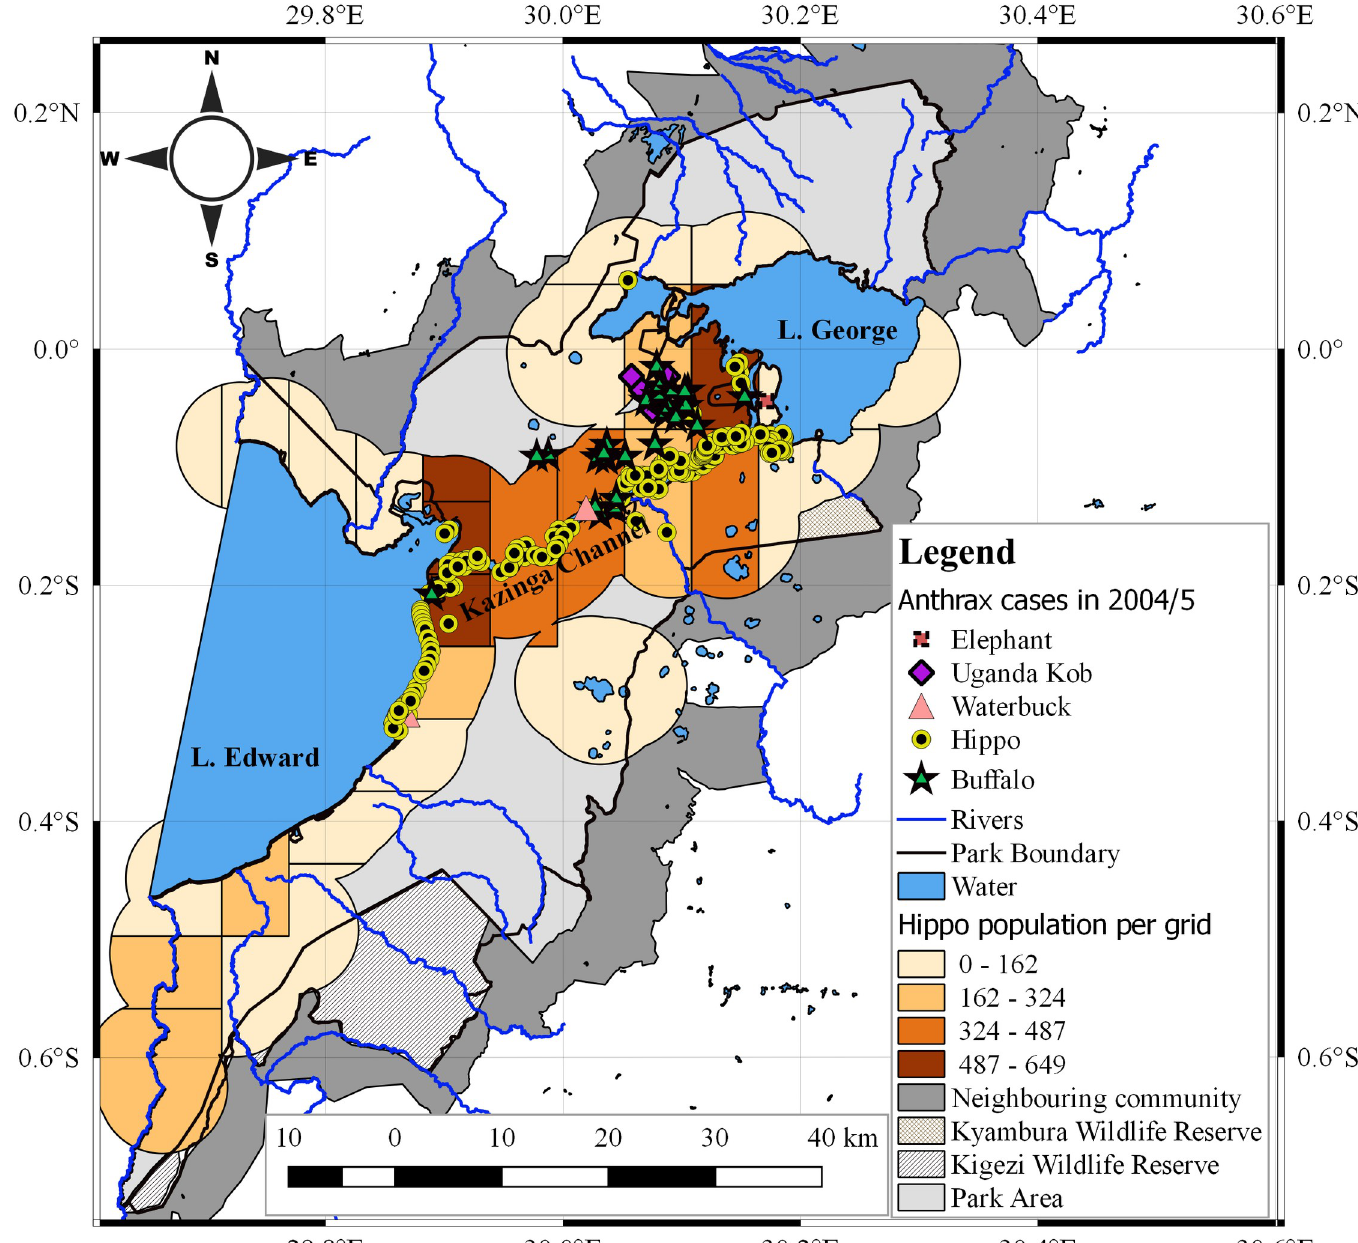
Fig 1. Spatial distribution of anthrax cases relative to hippo population size in 2004/5 outbreak. Symbols represent case locations. Colour ramp from light to dark on gridded rectangle cells represent increasing number of at-risk hippos within a 6 km radius buffer zone. Hippopotamus amphibious live in water during day, congregating in social groups called schools. They walk out at night an average of 3–6 km to graze [4]. A buffer of 6 km radius was generated around each geo-referenced school to map high risk areas for hippo anthrax outbreaks. The study area was overlaid with 6 x 6 km grid cells and clipped to the buffers. Twenty-seven (n = 27) grid cells were used